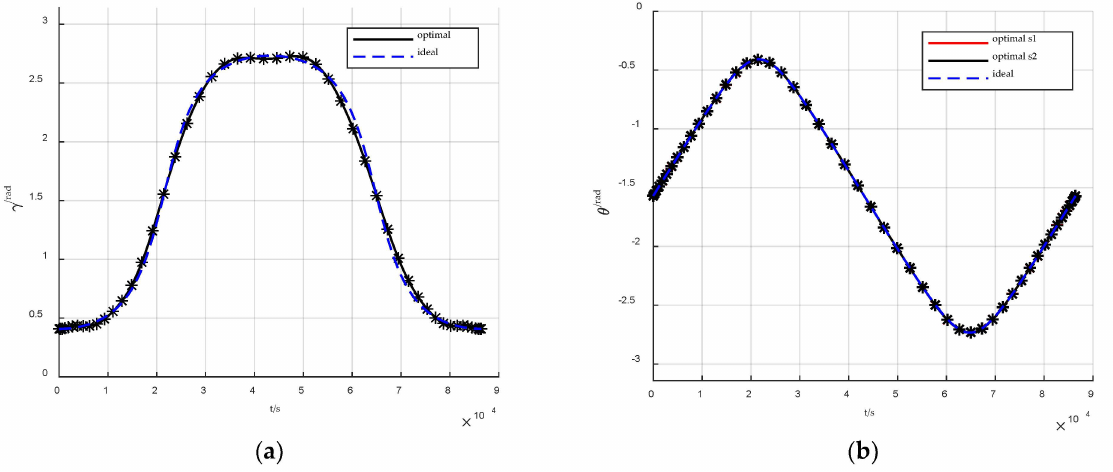
Figure 3. Angular trajectory around solstice. ( a ) Angular trajectory of γ ; ( b ) angular trajectory of θ j